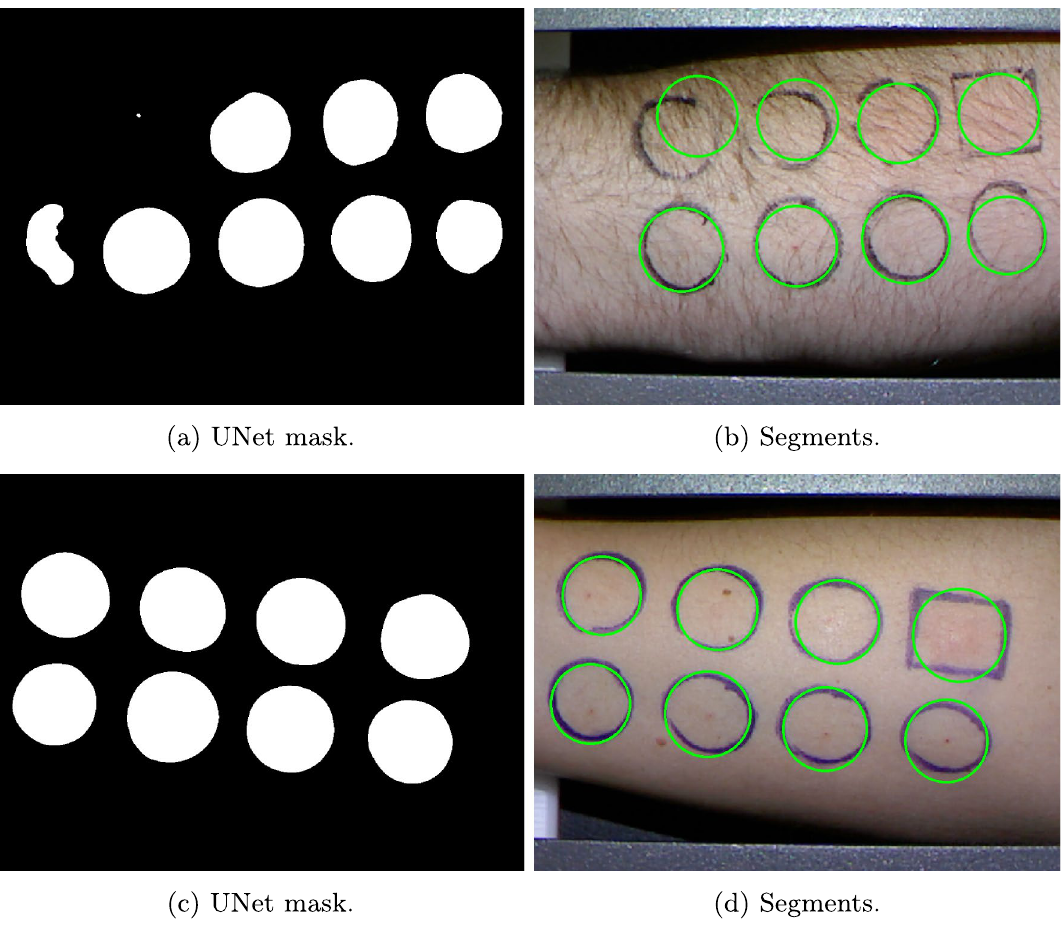
Figure 3. Sample segmentation results for problematic image. First row shows the result for a hairy forearm, while the second row shows the result for a different marker color (blue).